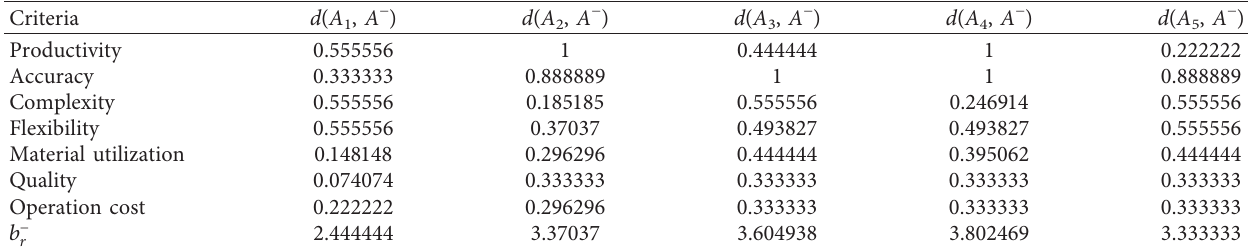
Table 9: Rating of each alternative from A − (NIS).